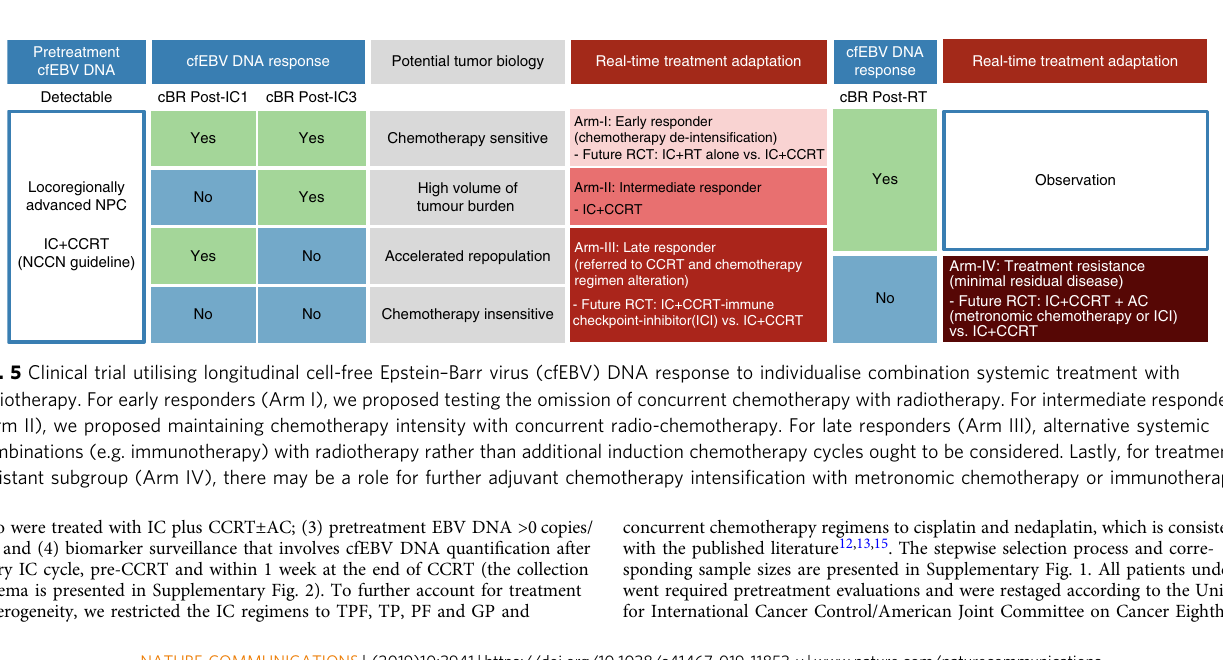
Fig. 4 Survival outcomes with varying chemotherapy intensities for the respective response phenotypes. Disease-free (DFS), overall (OS), distant metastasis-free (DMFS), and locoregional relapse-free survival (LRFS) for a intermediate and late responders with complete biological response (cBR) post-IC 2 , b intermediate and late responders without cBR post-IC 2 and c treatment-resistant subgroup